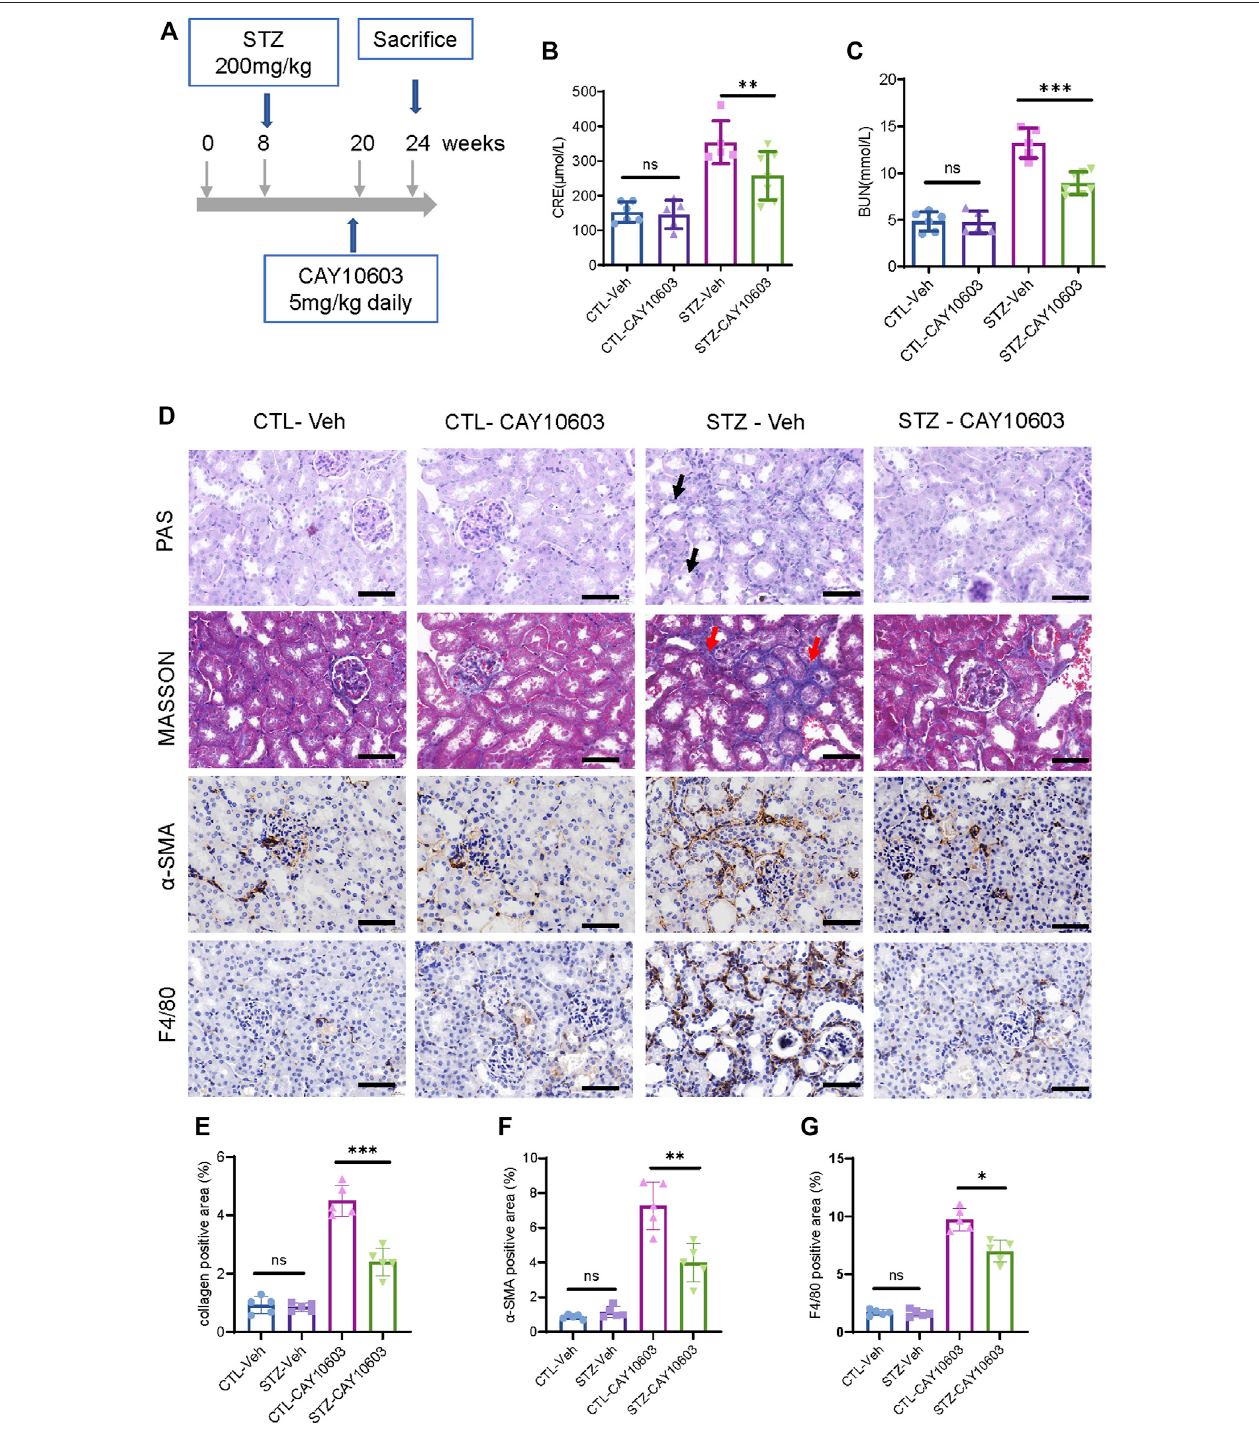
FIGURE 5 | CAY10603 delays kidney function decline in the late stage of diabetic mice. (A) Schematic diagram of experimental design. (B) Serum creatinine and (C) serum BUNindifferentgroupsasindicated. (D) RepresentativeimagesofPASstaining,Massonstaining,and IHCstainingof α -SMAandF4/80. (E) Quanti fi cationof the positive area for Masson staining. (F) Quanti fi cation of the positive area for α -SMA IHC staining. (G) Quanti fi cation of the positive area for F4/80 IHC staining. * p < 0.05; ** p < 0.01; *** p < 0.001. Scale bar, 100 µm. Two-way ANOVA. CTL, control; Veh, vehicle.